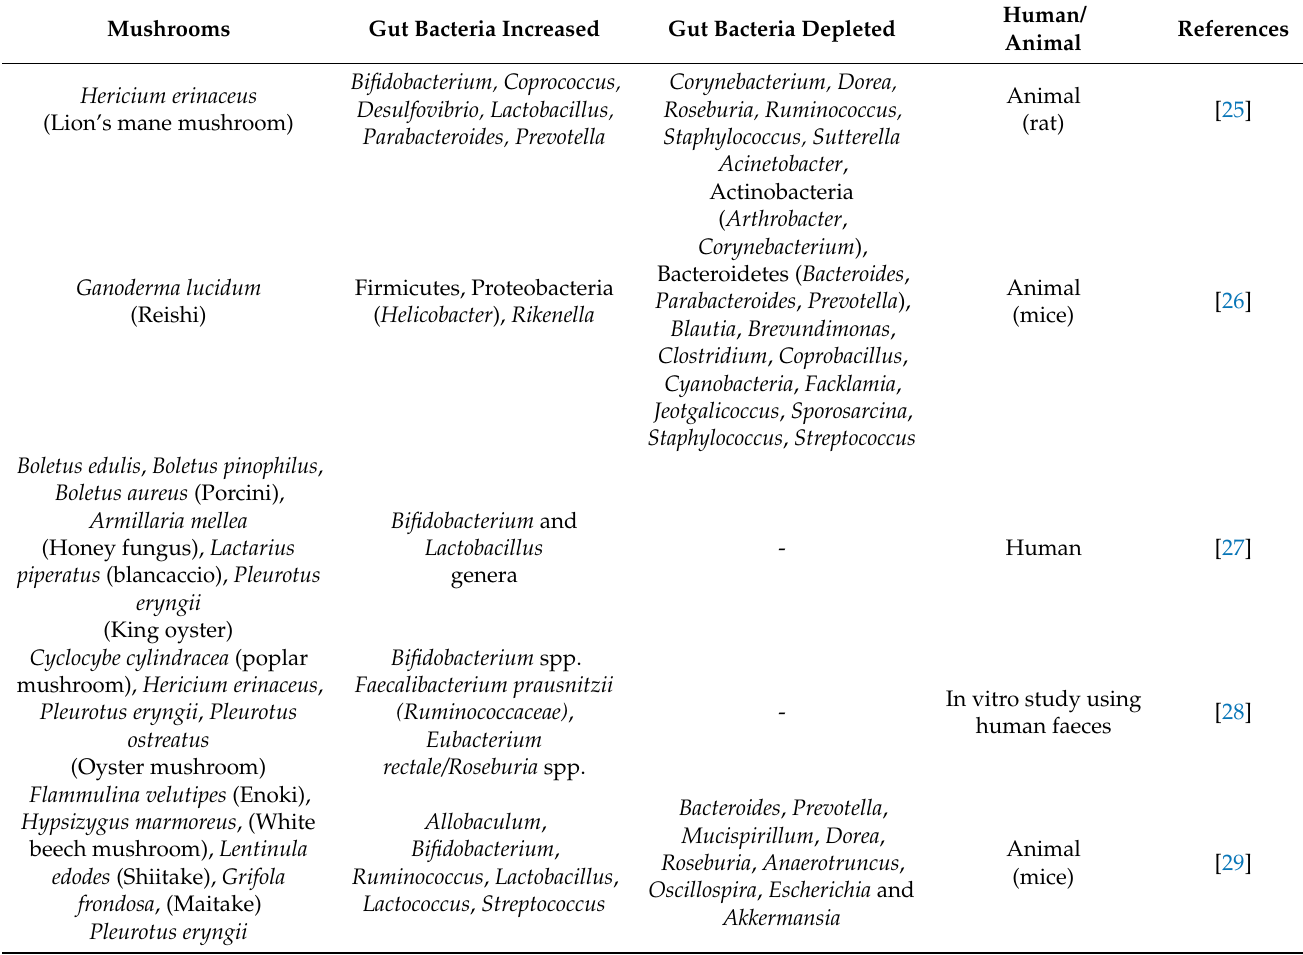
Table 1. Impact of mushrooms consumption on gut microbiota